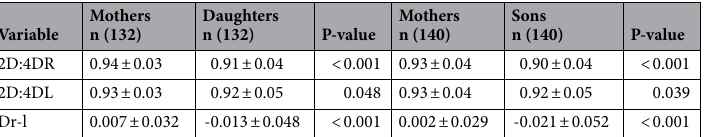
Table 4. Comparing digit ratios between mothers, their daughters and their sons. Results were presented as mean ± SD. Digit ratios of mothers were compared to their daughters and their sons using student t -test (unpaired, 2-tailed).